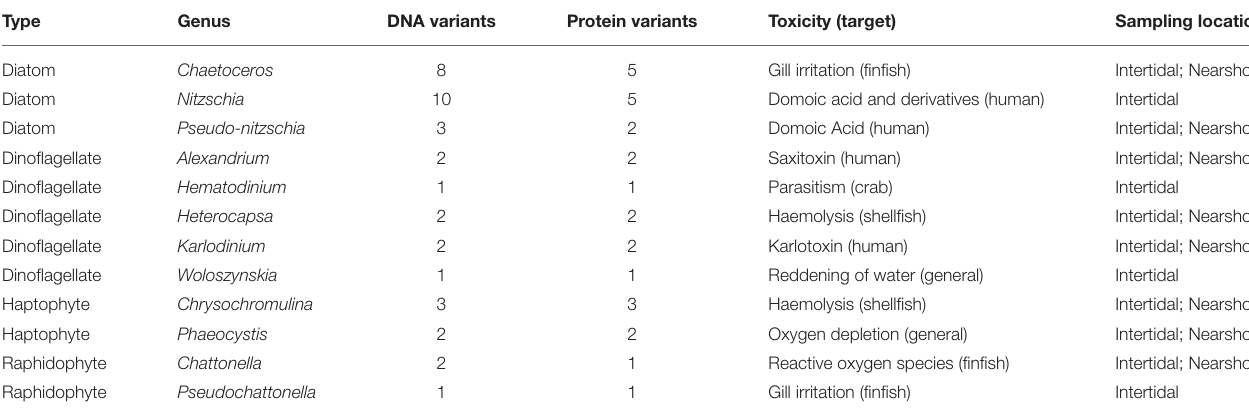
TABLE 1 | Potential harmful algal taxa identified by eDNA in at least ten percent of samples from in Hood Canal,